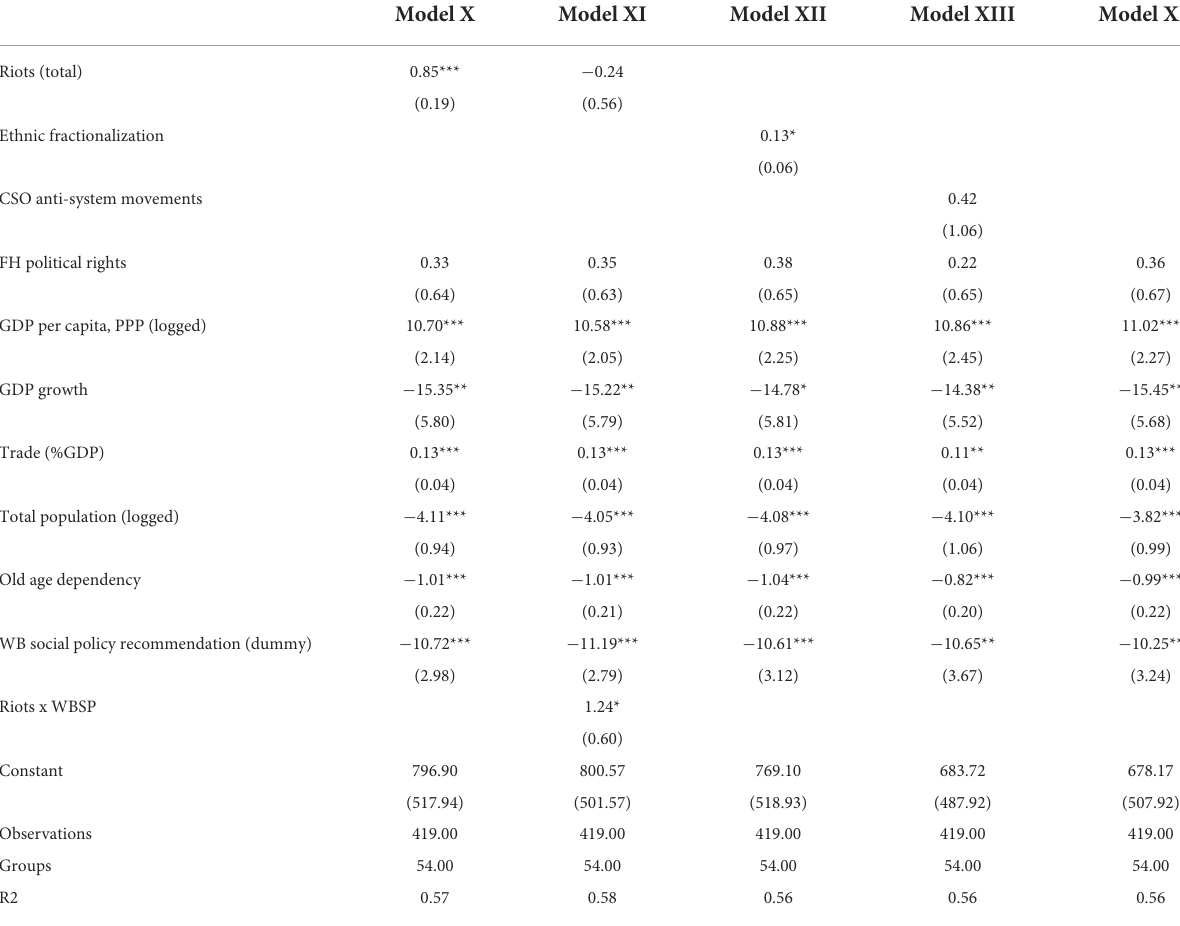
TABLE 5 Alternative model